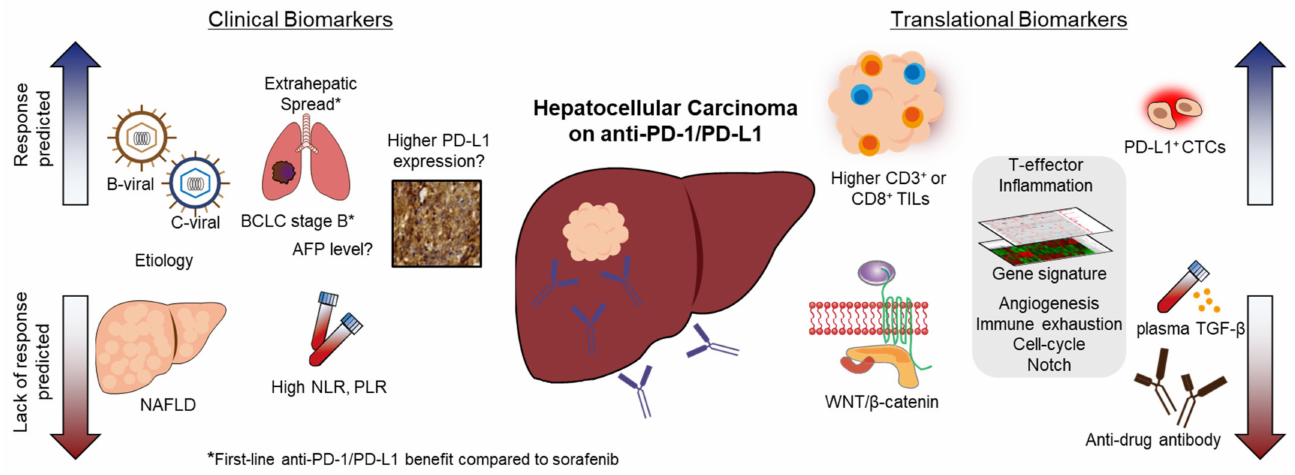
Figure 1. Clinical and translational biomarkers to predict the response and lack of response of immune checkpoint inhibitor treatment in hepatocellular